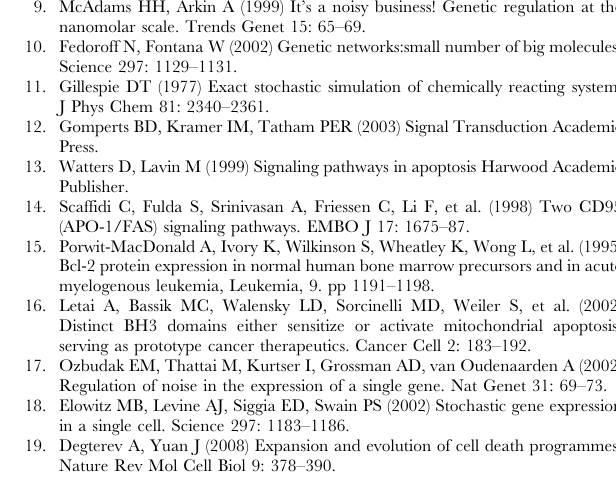
Figure S1 Differential signaling response of the minimal network as k 20 and x 0 are varied. This phase diagram is generated using two relations obtained from a parameter sensitivity analysis of the minimal model: (i) type A signaling dominates for all